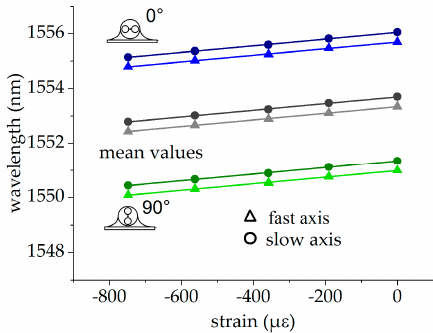
Figure 10. Strain calibration of the surface-attached PM tandem: FBG in the 0 ◦ -orientation in green, FBG in the 90 ◦ -orientation in blue, and mean values in grey. Table 3. Fitting parameters of the strain calibration of the PM tandem.